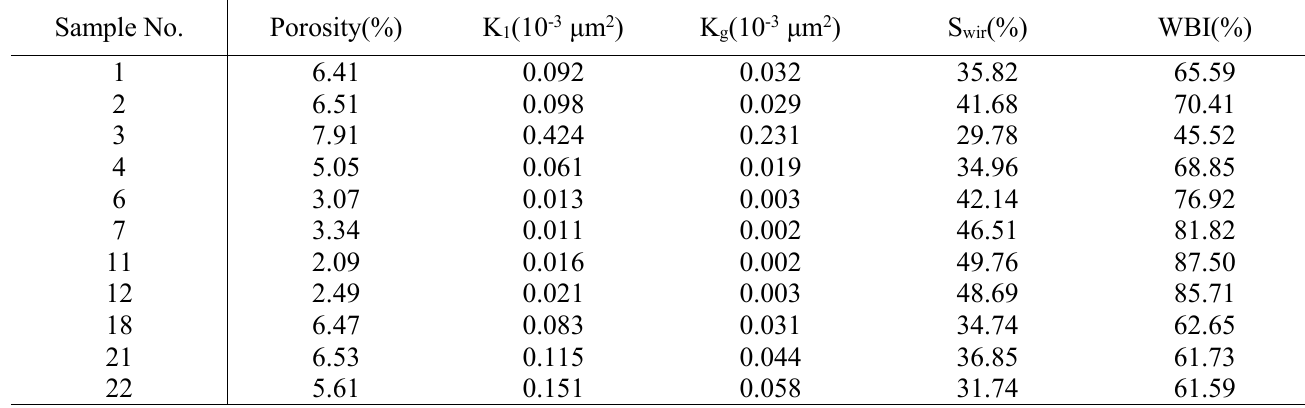
Table 2—Results of WBI for 11